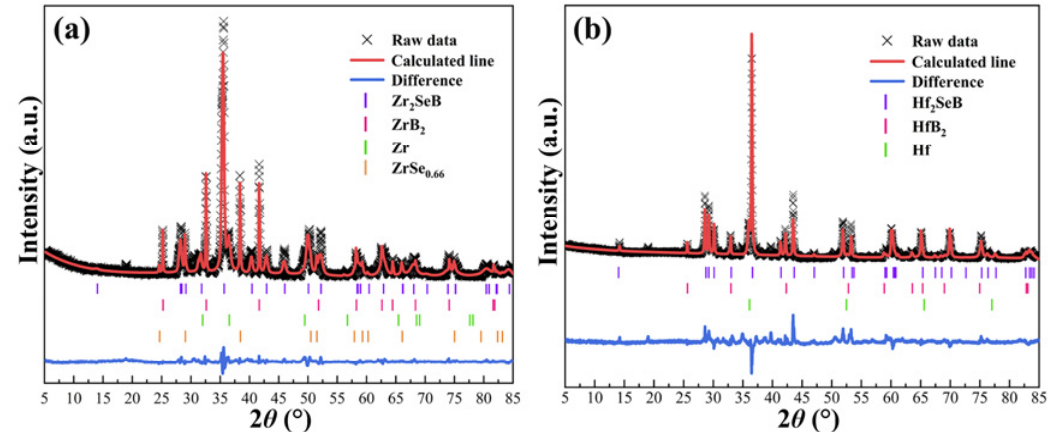
Fig. 5 Comparison of the observed (black cross) and calculated (red curve) XRD patterns of (a) Zr 2 SeB and (b) Hf 2 SeB samples. The blue curve represents the difference between the observed and calculated XRD